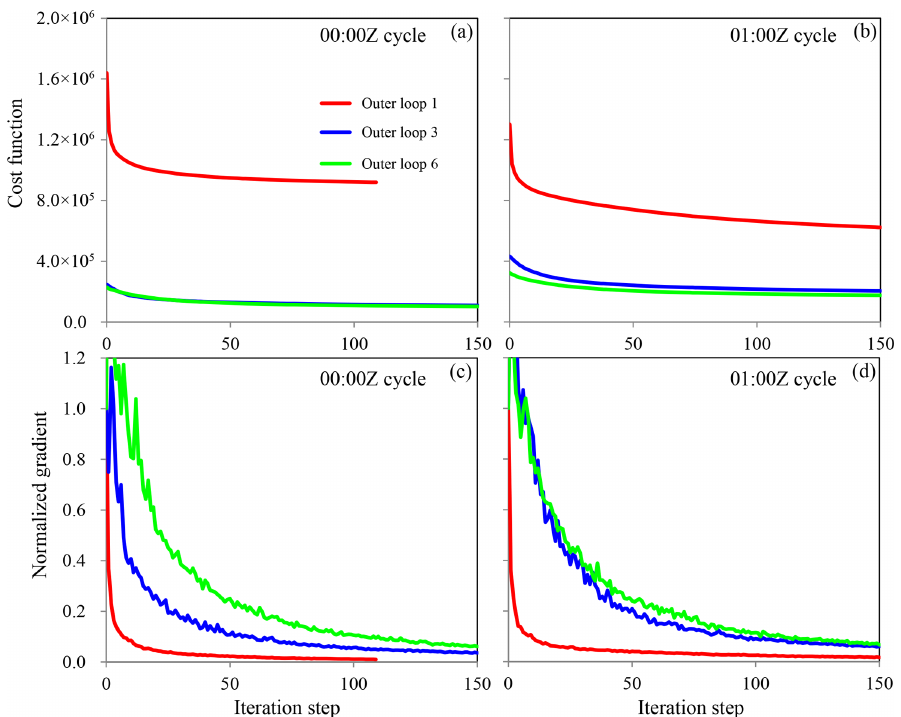
Figure 9. The cost function and normalized gradient norm as functions of the iteration step during the minimization at (a, c) 00:00Z and (b, d) 01:00Z in